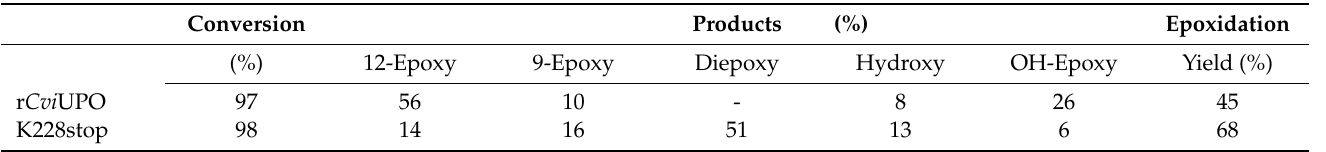
Table 4. Fatty acid conversion, percentages of main products, and epoxidation yield in the reac- tions of linoleic acid with native r Cvi UPO and the short-tail K228stop variant (see Figure S5 for chromatographic